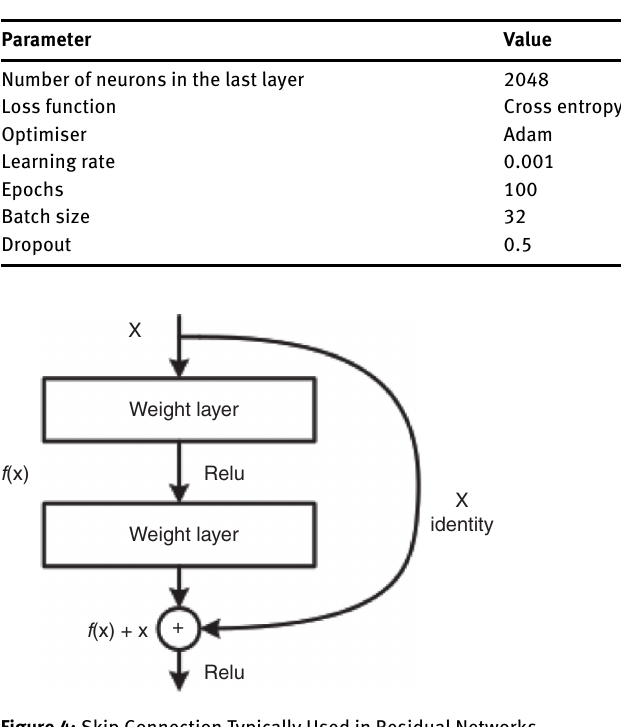
Table 1: Parameters Used for the Proposed Model.